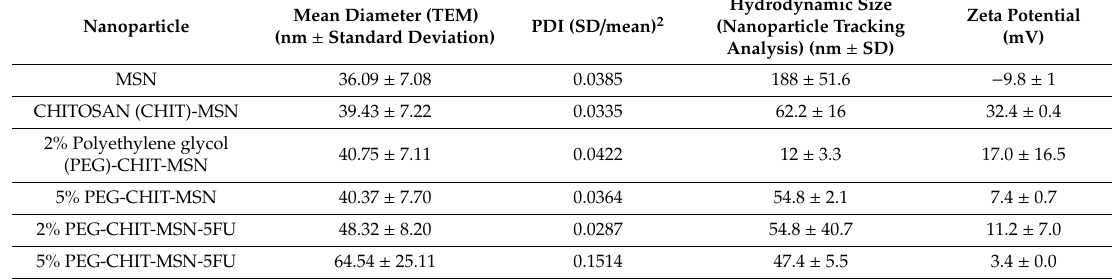
Table 1. Transmission electron microscopy (TEM) size, polydispersity index (PDI), hydrodynamic size, and zeta potential of all mesoporous silica nanoparticles (MSNs) and 5-fluorouracil-loaded mesoporous silica nanoparticles.